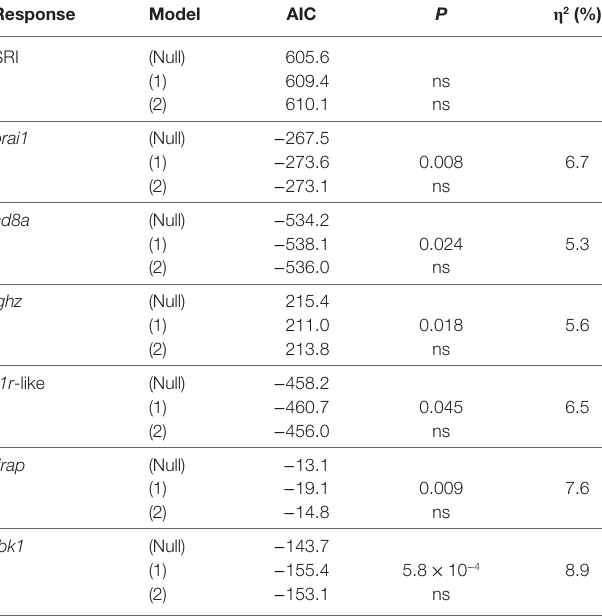
TaBle 4 | Cosinor regression models comparing scenarios of temporal and photoperiodic effect in the laboratory experiment ( n =